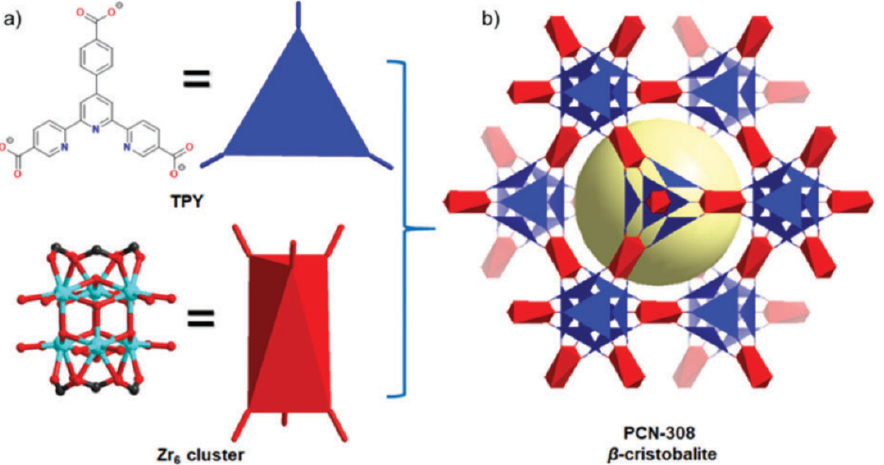
Figure 10. ( a ) Trigonal-planar organic linker TPY and six-connected D 3d -symmetric Zr 6 antipris- matic clusters. ( b ) The β -Cristobalite network of PCN-308 simulated based on the reported PCN-777 structure. Blue = TPY ligand, Red = Zr 6 cluster, Yellow = void space. Adapted with permission from [111]; Published by Royal Society of Chemistry, 2019.